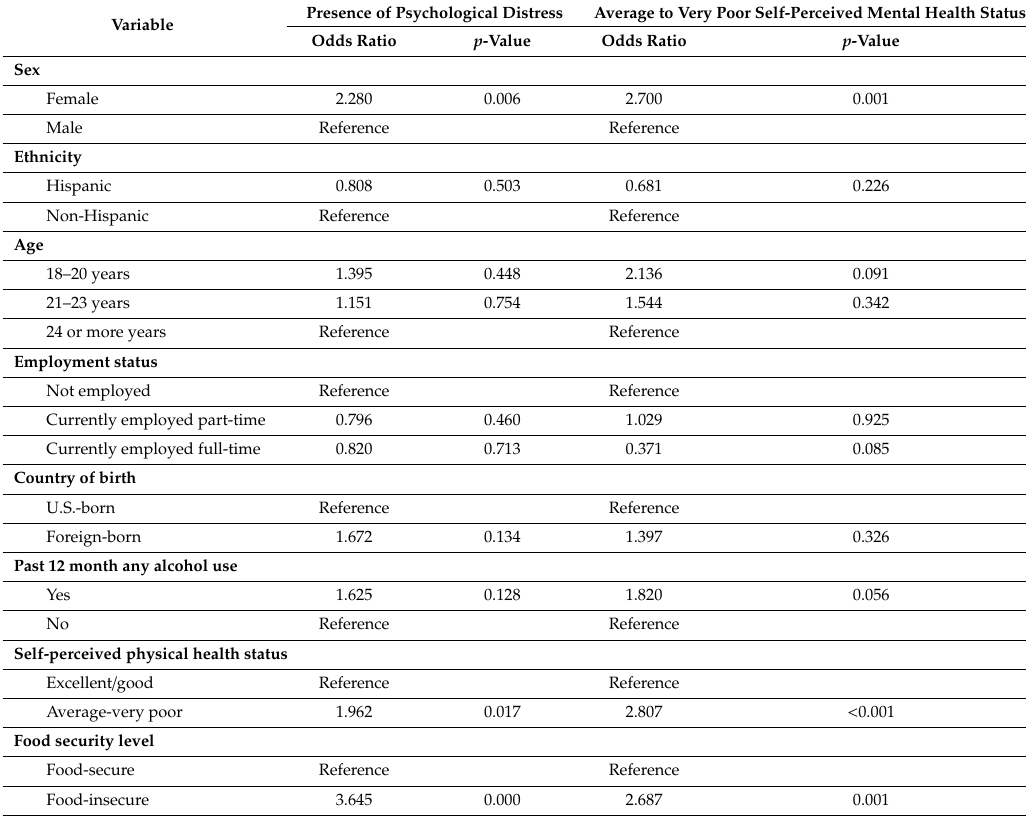
Table 4. Odds ratio of psychological distress and low self-perceived mental health status.